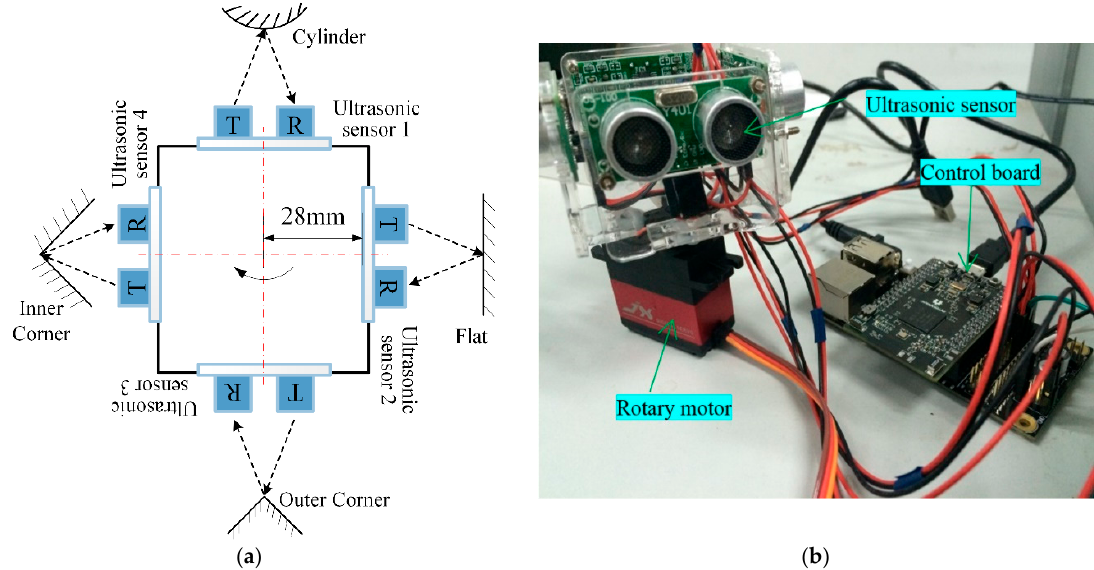
Figure 1. Configuration of ultrasonic array. ( a ) Schematic of ultrasonic sensor array; ( b ) experimental set-up.